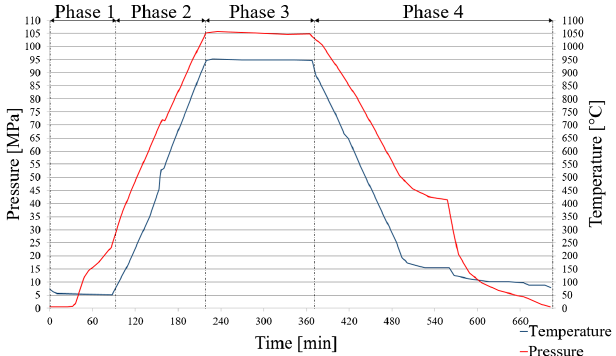
FIG. 5. Temperature and pressure over time of the HIP cycle performed for the prototype of cooling plate of the SPS beam